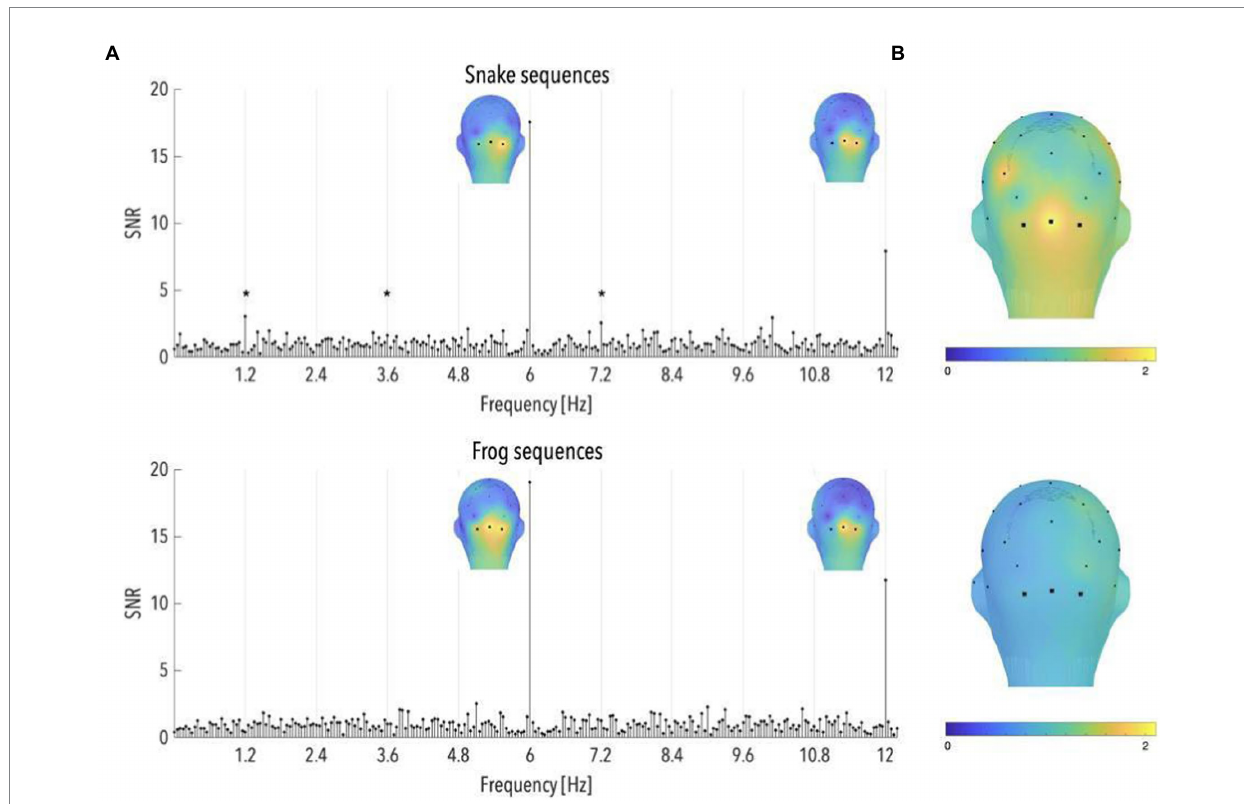
FIGURE 2 (A) Signal-to-noise ratio (SNR) spectra of category-selective and stimulation responses until 12 Hz, in the occipital region (data have been averaged across O1, Oz, and O2), and topographical maps of SNR over posterior scalp regions at stimulation frequencies, for snake and frog sequences ( n = 87 and 91, respectively). The topographies at 6 and 12 Hz are shown on their individual maximal color scales. The asterisk indicates a significant discrimination response in the occipital region, of colorful snake pictures. (B) Topographical maps of SNR averaged on the first six harmonics of the category-selective response, for snake and frog sequences (upper and lower part,